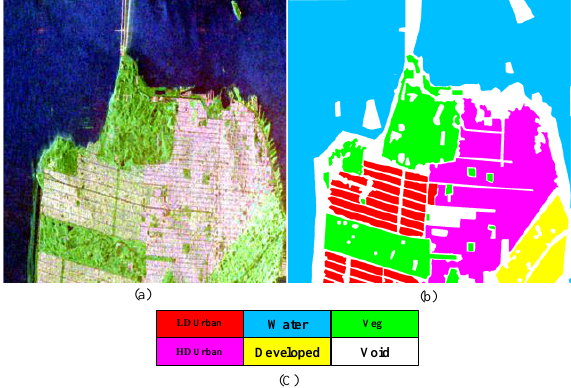
Figure 3. San. ( a ) Pauli RGB image. ( b ) GT. ( c ) Color